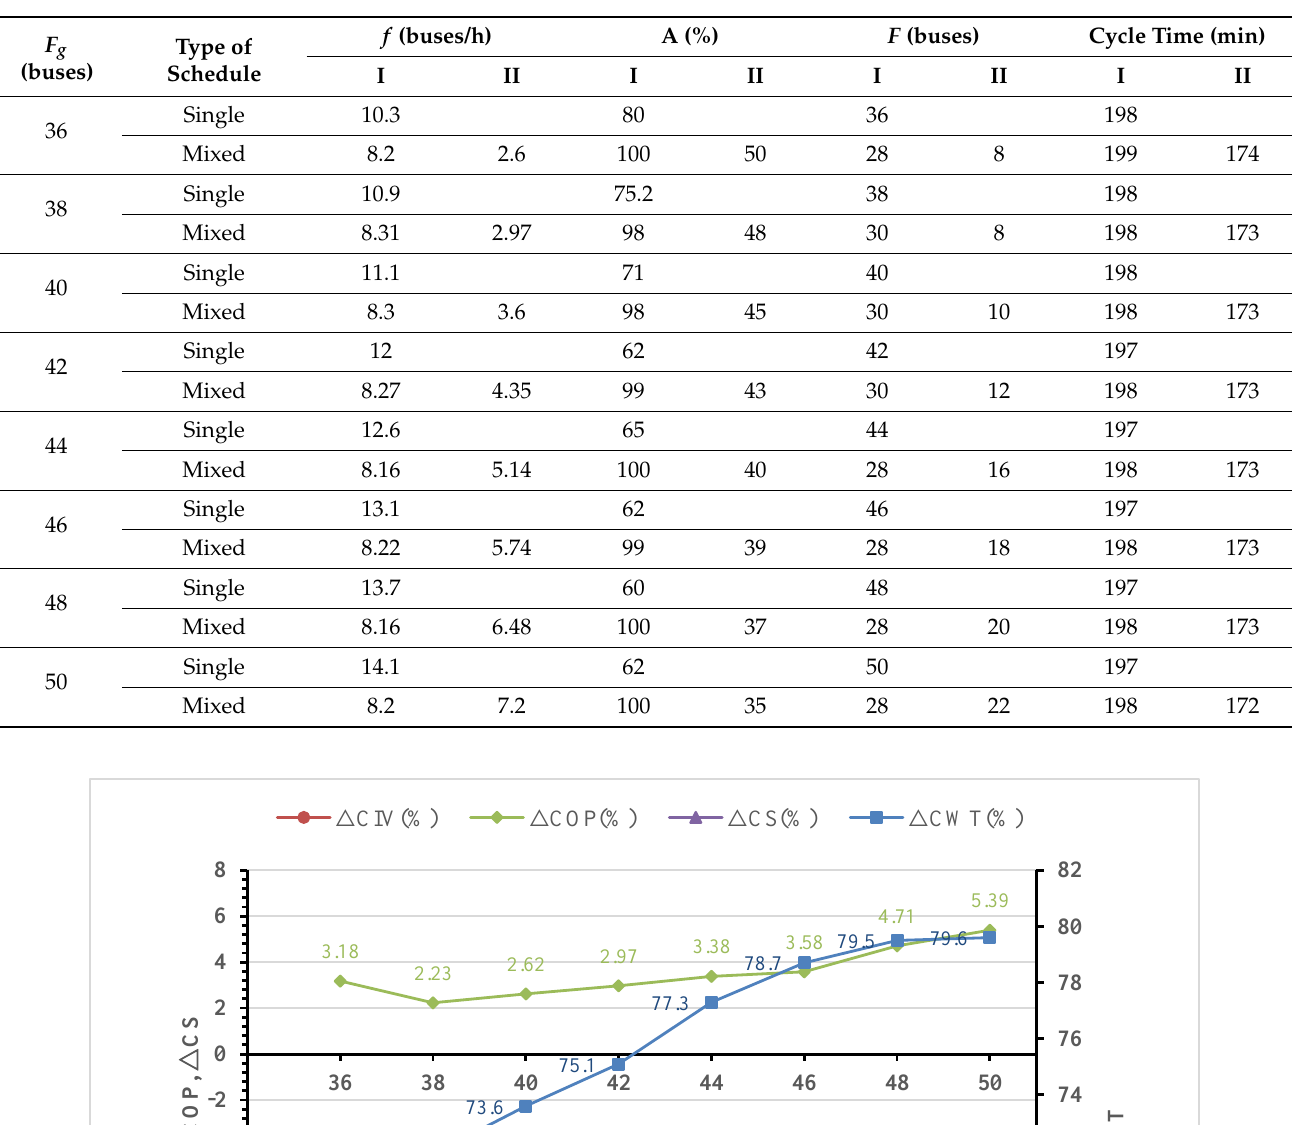
Table 3. Frequencies, fleet of different fleet size constraints.